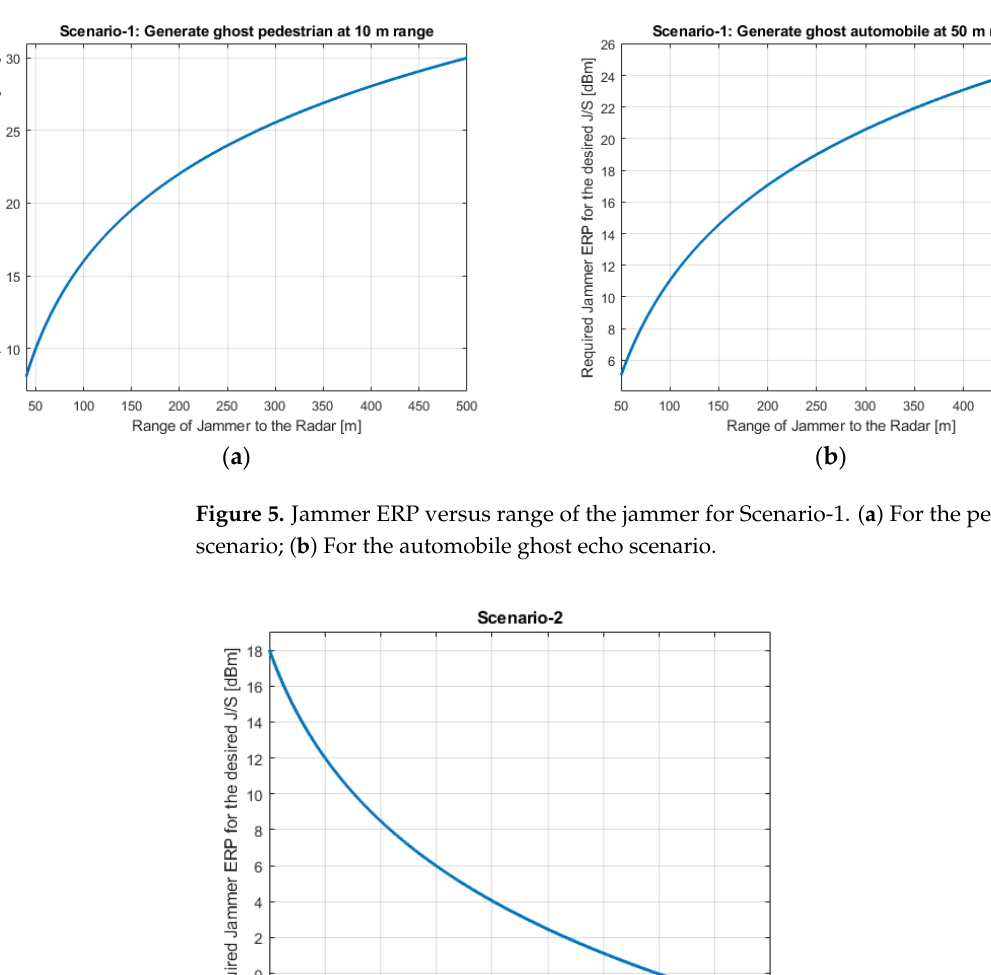
Figure 4. Scenario-4. An RVGPO/I technique for spoofing the real automobile echo.